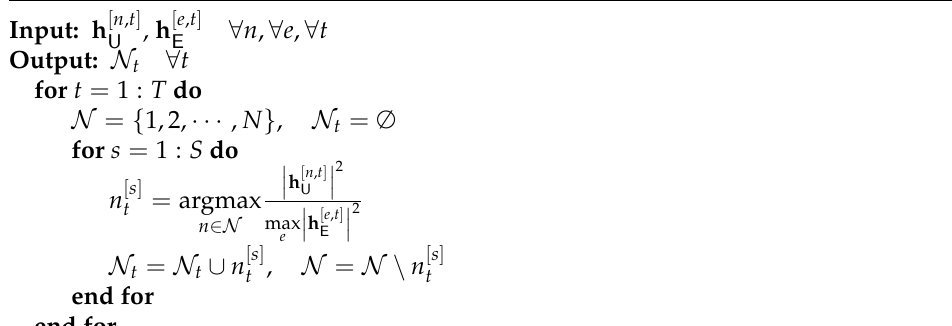
Algorithm 1 Time slot allocation algorithm for user equipment (UE)